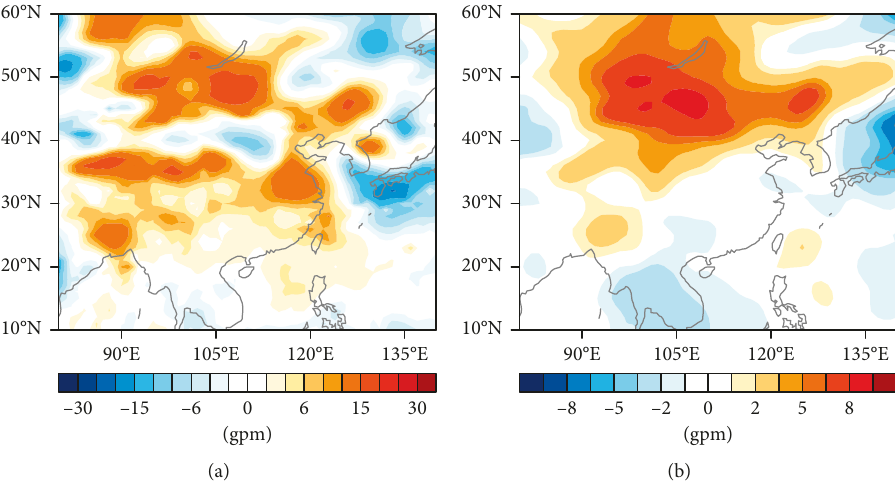
Figure 3: 24h nonsystematic error of geopotential height on 500hPa on July 6, 2010 (unit: gpm): (a) nonsystematic error and (b) nonsystematic error estimated by variational approach.